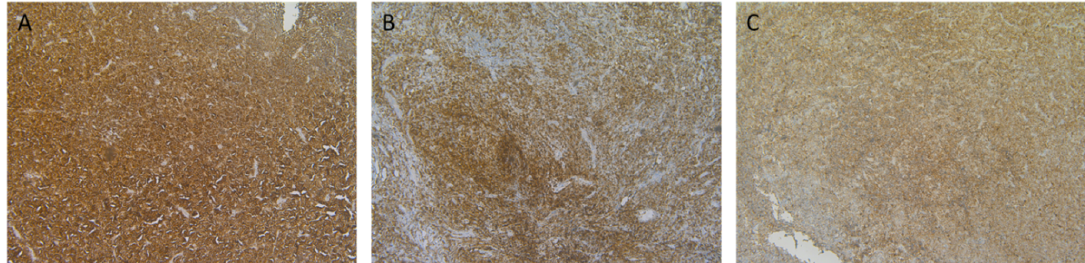
Figure 3. Representative micrographs of CD70 immunohistochemical staining on samples of patients with haematological malignancies. ( A ) CD70 staining in a mantle cell lymphoma; ( B ) cutaneous T-cell lymphoma; and, ( C ) diffuse large B cell lymphoma is shown. Magnitude 100×.